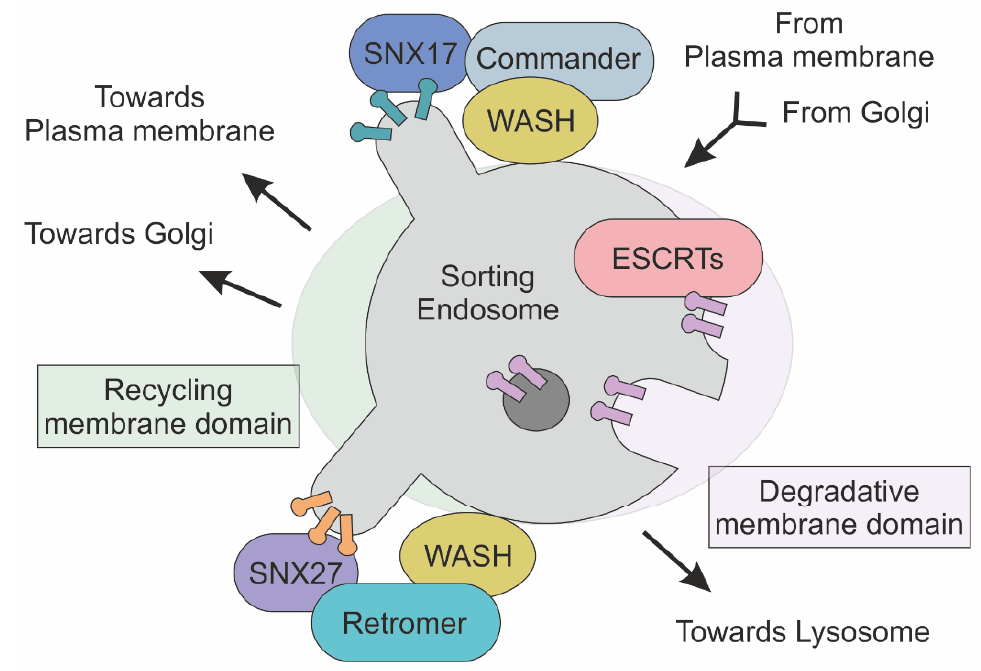
Figure 2. Schematic representation of Commander, ESCRT and Retromer complexes at the sorting endosome. Transmembrane cargoes are directed to plasma membrane, Golgi and Lysosome are accumulated in endosome. In this membrane-bound compartment, the Commander complex, to- gether with the SNX and WASH complexes, mediates the sorting of cargoes to the plasma membrane. In parallel, ESCRT complexes recognize and direct ubiquitylated protein towards the lysosome for degradation. The Retromer complex, in association with the SNX and WASH complexes, defines transport towards both Golgi and the plasma membrane through the association of different SNX proteins.